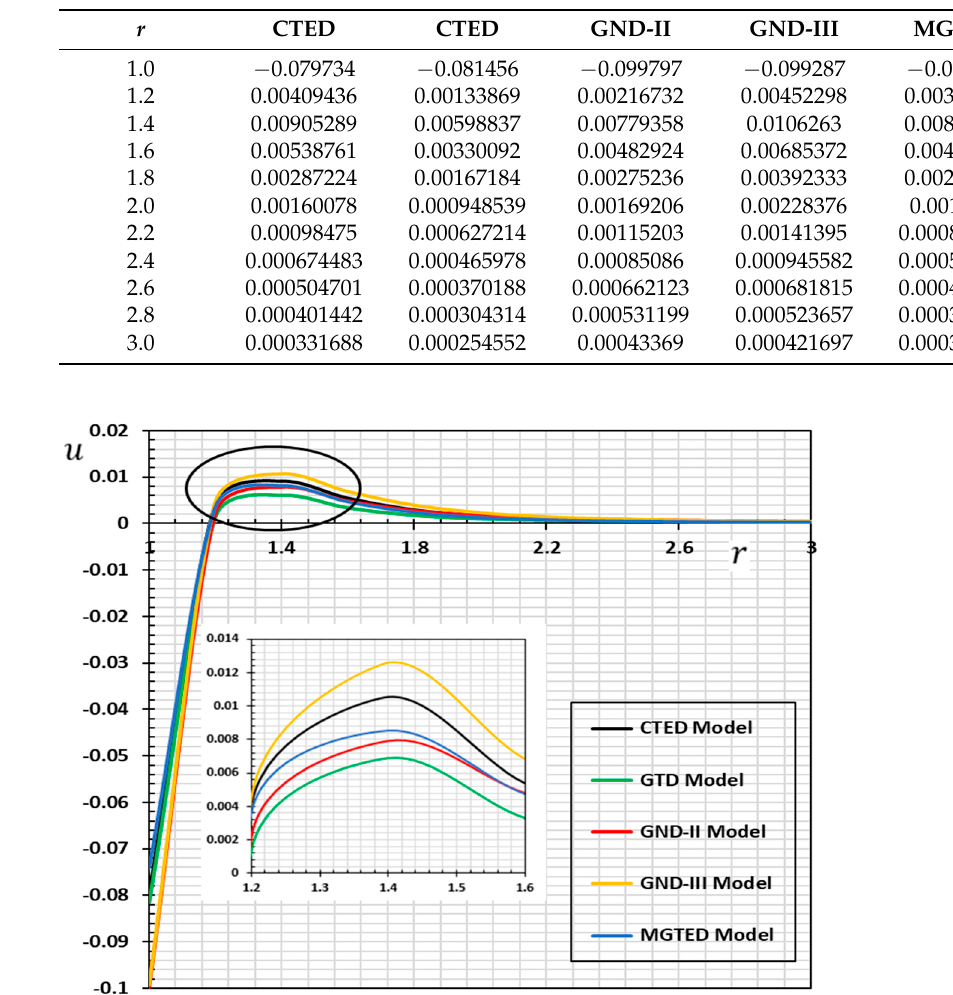
Table 2. The displacement 𝑢 for different thermo-diffusion models.